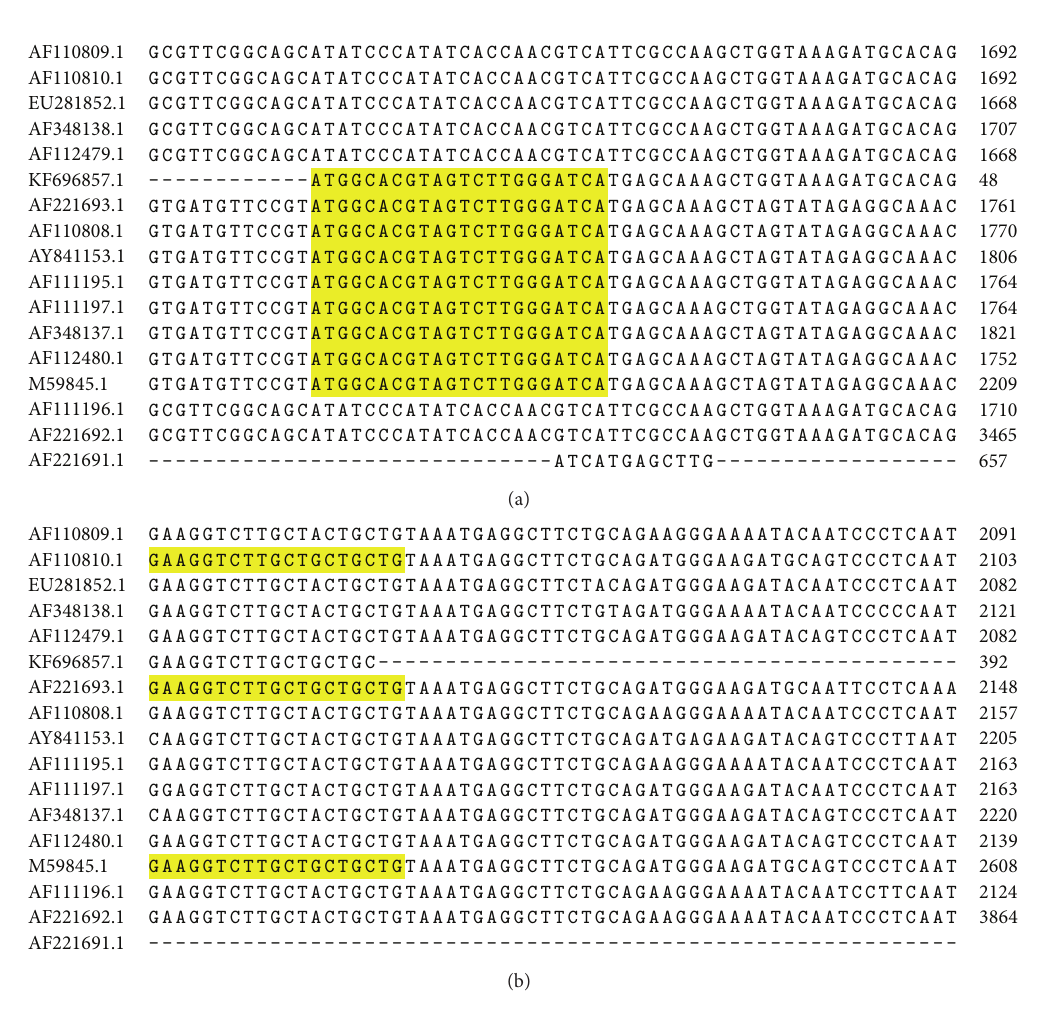
Figure 6: (a) Multiple sequence alignment of various geographic isolates of A. marginale showing variations at forward primer binding site of msp1 𝛽 used in the present study. (b) Multiple sequence alignment of various geographic isolates of A. marginale showing variations at reverse primer binding site of msp1 𝛽 used in the present